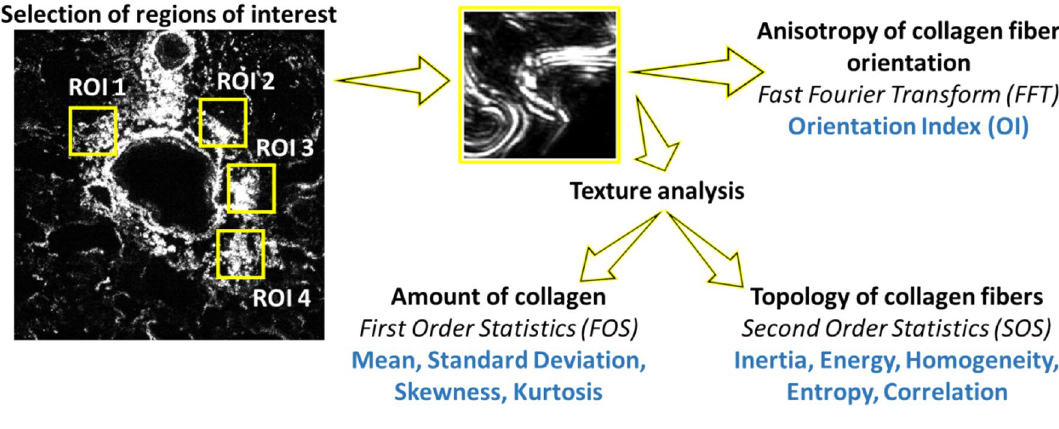
Figure 6. Procedures of SHG image